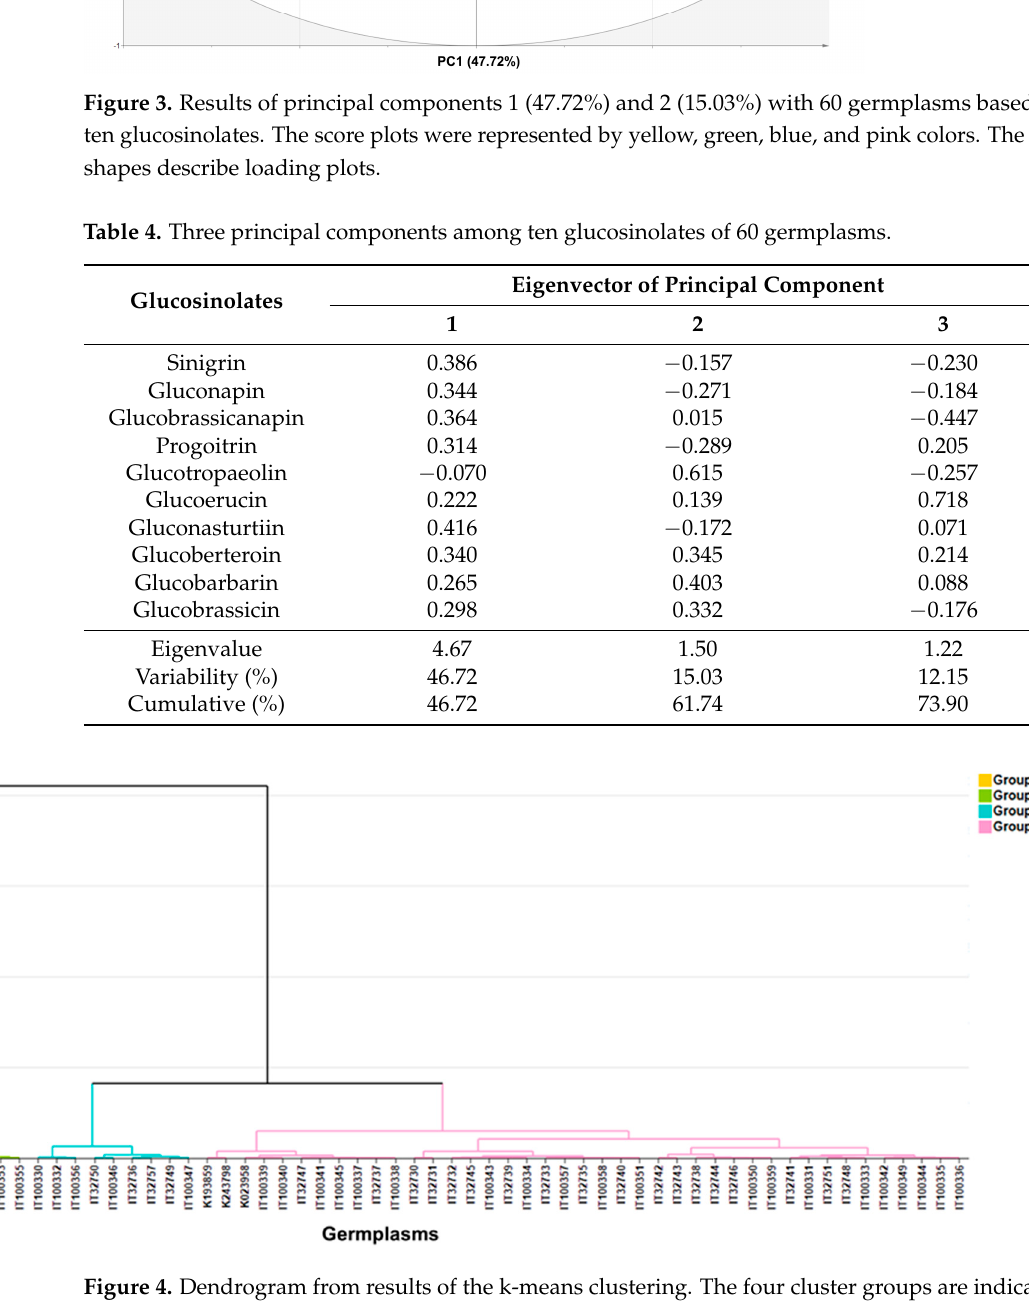
Table 5. Information status and origin in germplasms divided by four clusters.